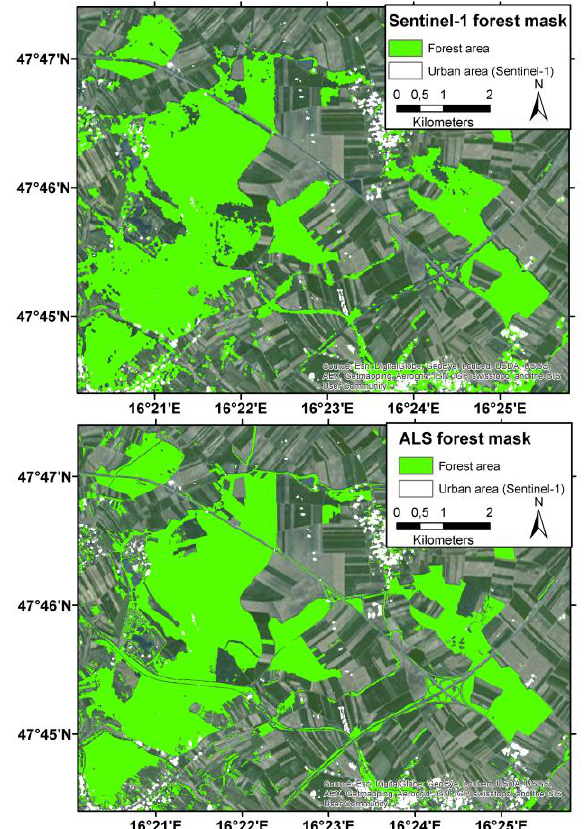
Figure 7: Subset of the ALS and Sentinel-1 based forest mask showing the clear-cut and forest grow changes between April 2010 and winter 2014/2015. The masks are overlaid on the ArcGIS Online basemap